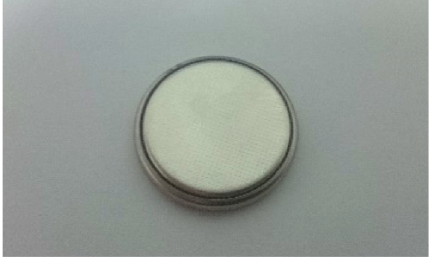
Figure 2: Supercapacitors used in the experiment.